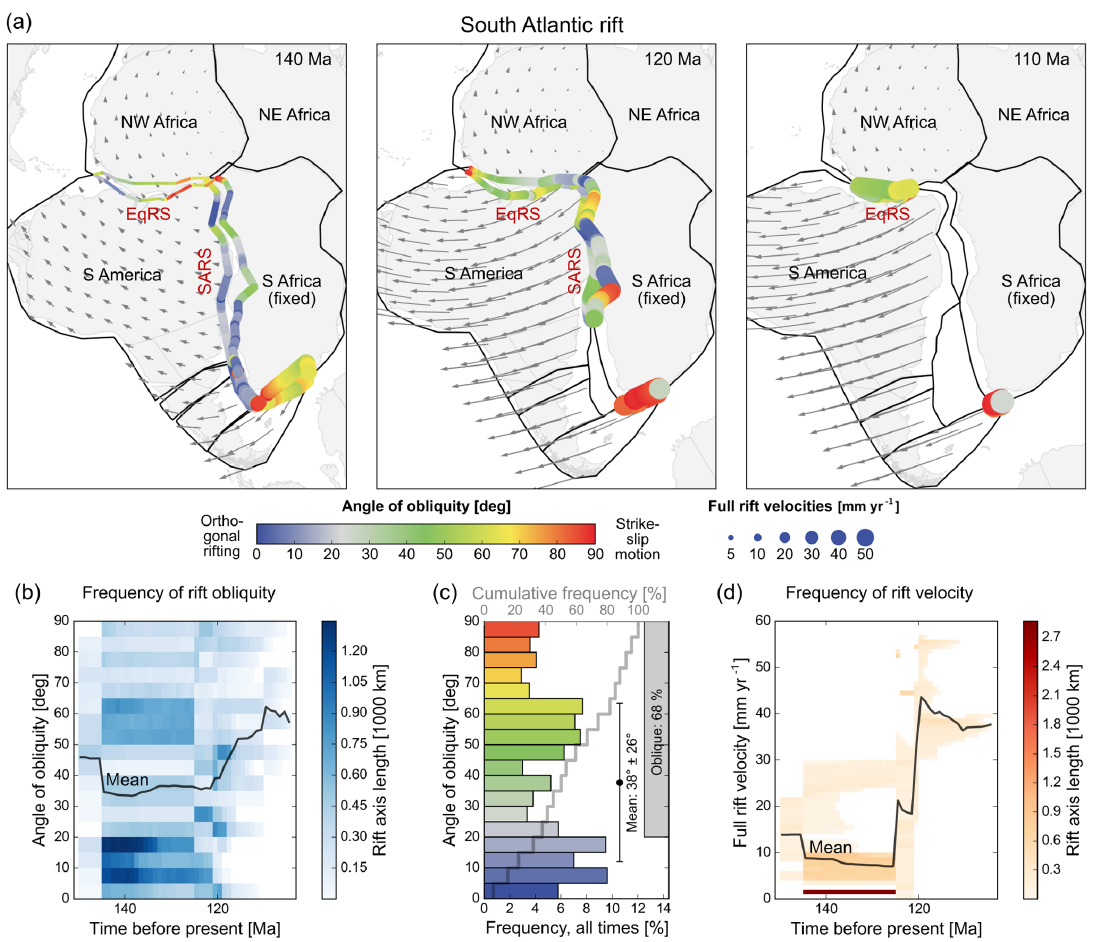
Figure 3. South Atlantic rift. (a) Tectonic reconstruction of continental polygons. The magnitude of the local relative plate velocity along the rift system is represented by circle size, rift obliquity by circle colour. Relative velocities of continents with respect to a fixed south Africa are depicted as grey vectors. All velocities are based on the global reconstruction of Müller et al. (2016) and analysed using pyGPlates. Low rift obliquity prevails in the central and southern segment of the South Atlantic rift, whereas high obliquities and strike-slip motion dominates the northern and southernmost segments. EqRS: Equatorial Atlantic Rift System, SARS: South Atlantic Rift System. (b) Frequency of rift obliquity in terms of rift axis length. The colour displays the integrated length of all rift segments that deform at the same rift obliquity. (c) Cumulative distribution of rift obliquity throughout the entire rift event. Bar colour represents obliquity. (d) Time-dependent frequency of rift velocity in terms of rift axis length. Colour shows integrated length of all segments deforming at the same velocity. Note that rift velocity and obliquity increase jointly starting at